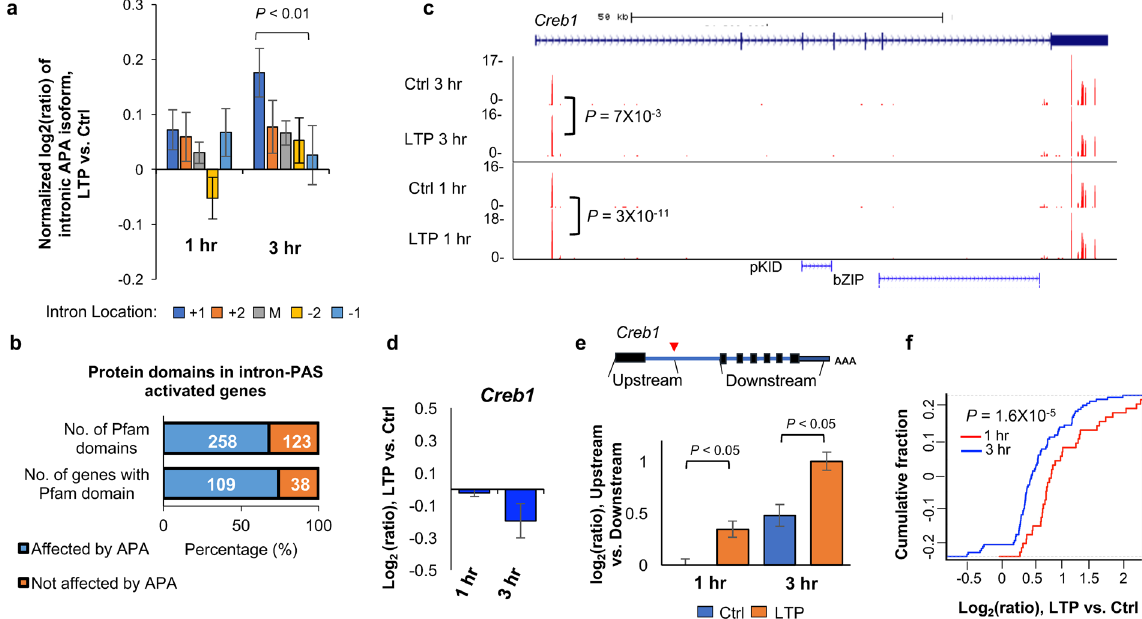
Figure 5. Characteristics of intronic APA after LTP induction. ( a ) Normalized expression changes of intronic PAS isoforms. Intronic PAS isoforms were divided into five groups based on the intron location where PAS resides, i.e., first ( + 1), second ( + 2), last ( − 1), second to last ( − 2), and middle (between + 2 and − 2 introns). Expression changes are expressed as log2(ratio), LTP vs. Ctrl. Only genes with ≥ 4 introns and only PAS isoforms with ≥ 2 reads were used for analysis. Values for five intron groups were normalized by mean-centering. Error bars are standard error of mean. P-value (Wilcoxon rank sum test) indicating difference between first and last intron values is shown. ( b ) Protein domains that can potentially be removed or truncated by intronic PAS activation. Number of pfam domains that can be removed or not removed by intronic APA is indicated in the upper bar, and number of genes that contain domains removed or not removed by intronic PAS activation is indicated in the lower bar. ( c ) An example gene Creb1 , which displayed significant intronic PAS activation. Gene structure is shown on top and peaks for PASs are shown in UCSC genome browser tracks. P-values based on comparison of intronic PAS and 3 ′ UTR PAS (DEXSeq) are indicated. Pfam domains are indicated. Reads are acquired by combining samples. ( d ) Gene expression change of Creb1 after LTP. ( e ) Expression changes based on RNA-seq reads mapped to different regions of Creb1 . Schematic of Creb1 is shown on the top, and log2(ratio) from indicated region is shown in a bar plot. Two regions were analyzed, including the region from transcription start site to the intronic PAS, and the region from the second to the last exons. ( f ) Gene expression changes (LTP vs. Ctrl) of CREB1 target genes obtained from the IPA database. The blue curve corresponds to 81 target genes in the 3 hr post LTP samples, whereas the red corresponds to 37 target genes in the 1 hr post LTP